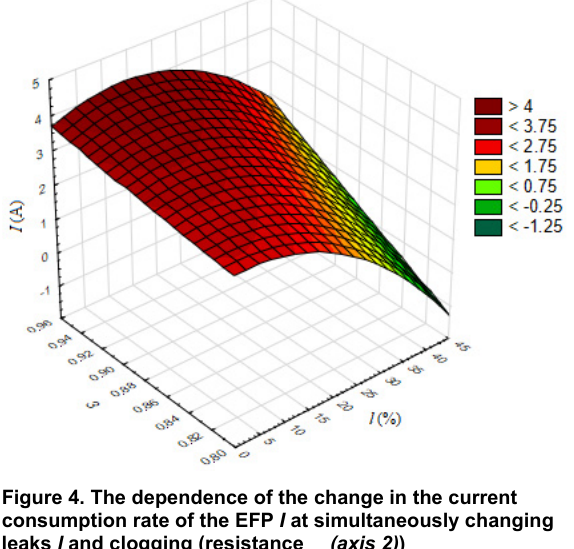
Figure 4. The dependence of the change in the current consumption rate of the EFP I at simultaneously changing leaks l and clogging (resistance (cid:31) (axis 2) )